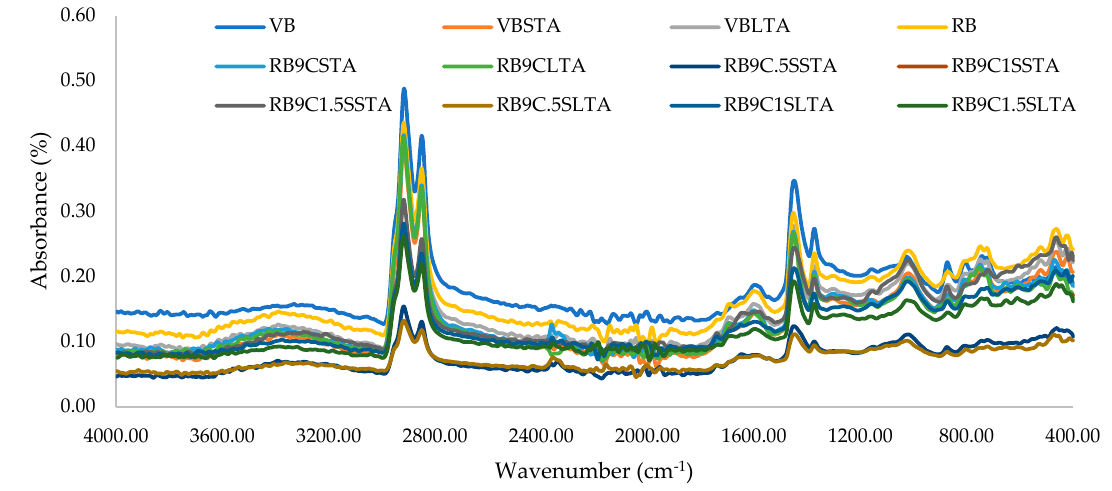
Figure 6. Effect of rejuvenation and aging on FTIR spectra of binders. Figure 6. E ff ect of rejuvenation and aging on FTIR spectra of